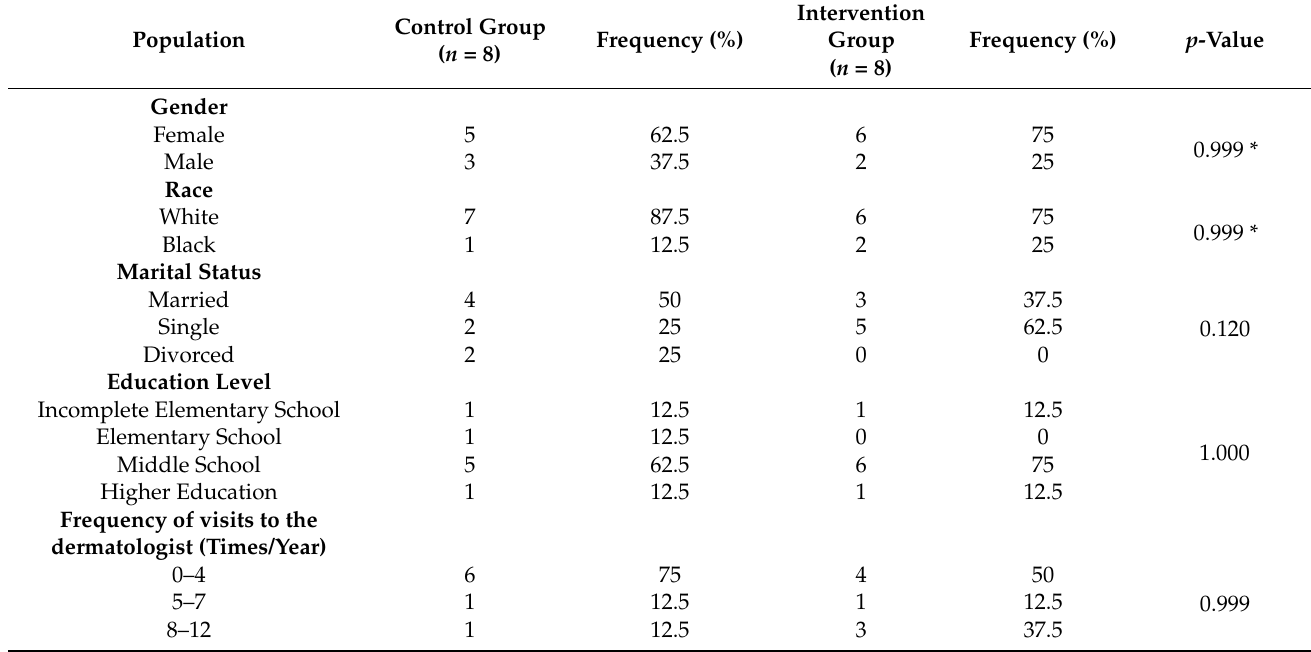
Table 2. Sociodemographic data and access to the patients’ health